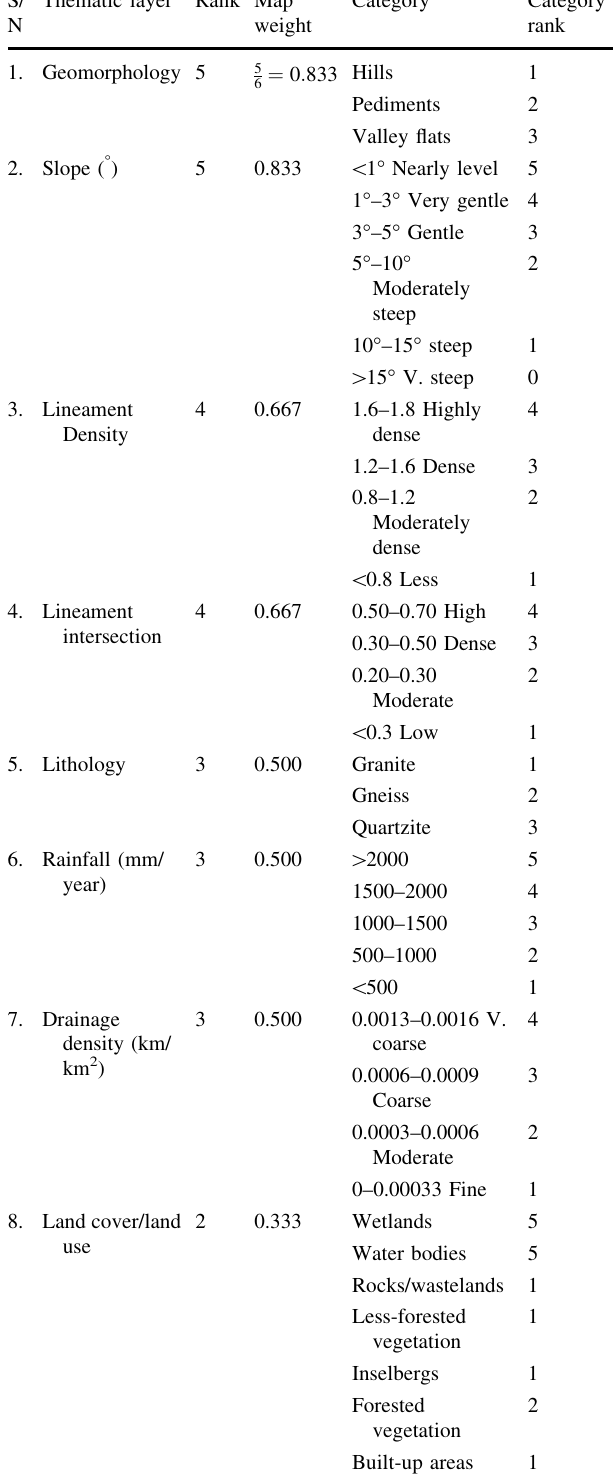
Table 1 Thematic layers, their categories, and their weights S/ Thematic layer Rank Map N